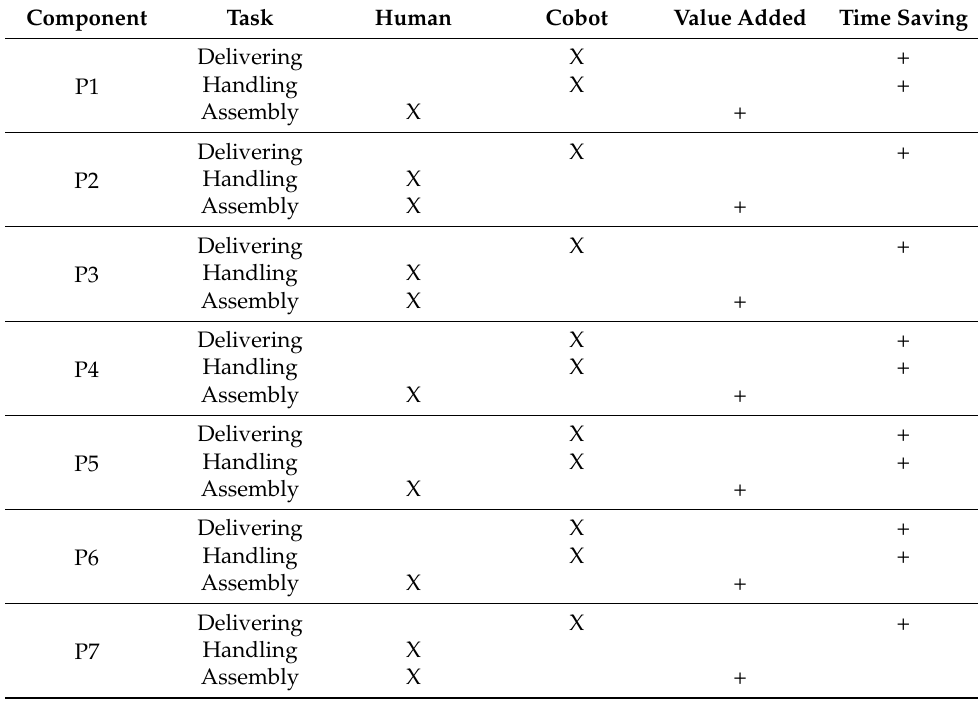
Table 8. Division of the workstation tasks. Component